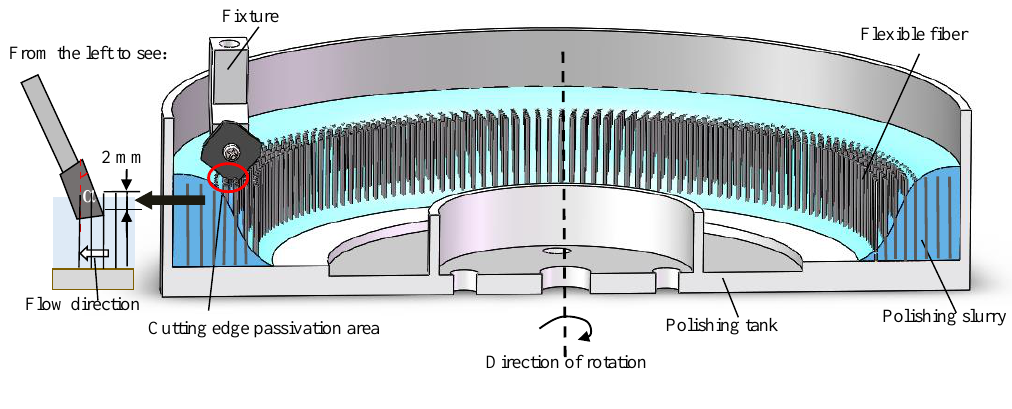
Figure 2. The FF-FRP experimental device ( a ) Schematic illustration. ( b ) Picture of experimental device.